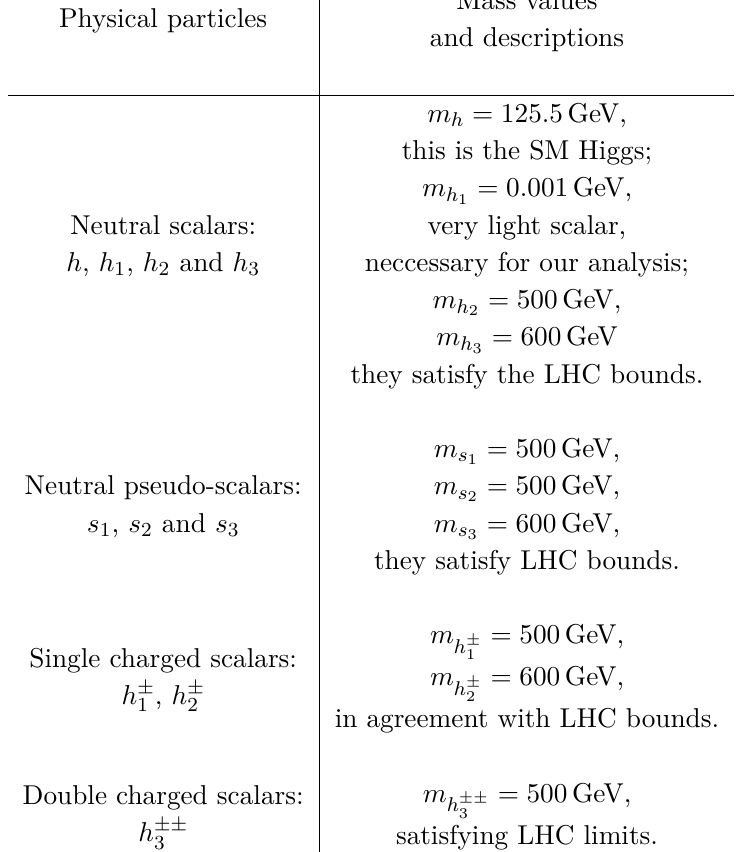
Table 2 . The physical scalar spectrum generated using the benchmark values from table 1. The physical scalar h is identified as the SM Higgs scallar. The h identified as φ 0 in the rest of the paper. The scalar masses are consistent with the LHC bounds.